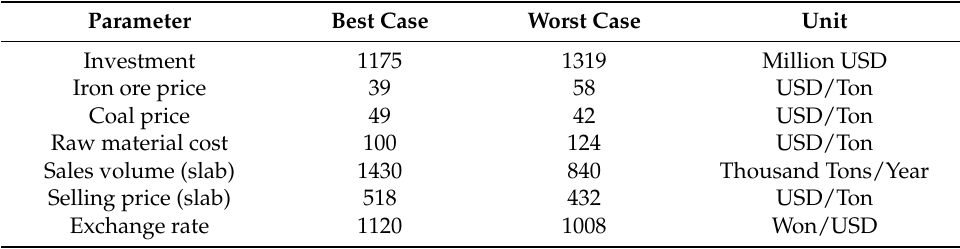
Table 7. Economic data for case study Project